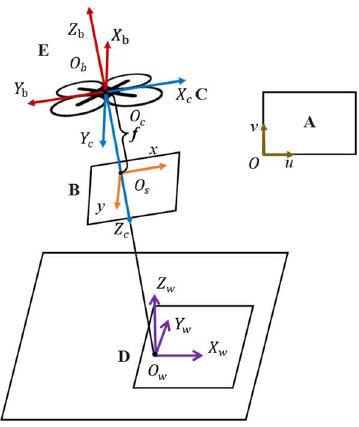
Figure 6. Relative position estimation coordinate system.